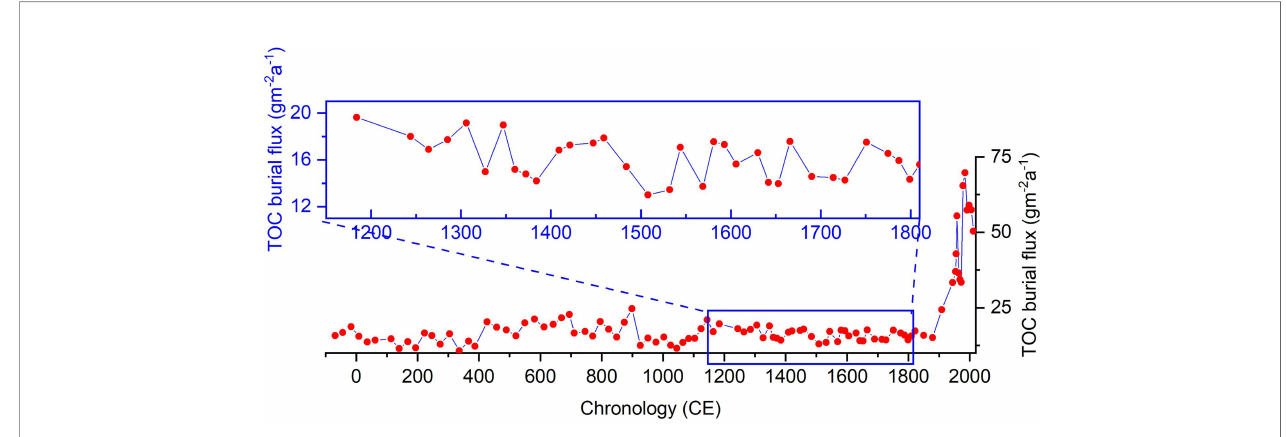
FIGURE 5 | The TOC burial fl ux of core C2 over the past 2000